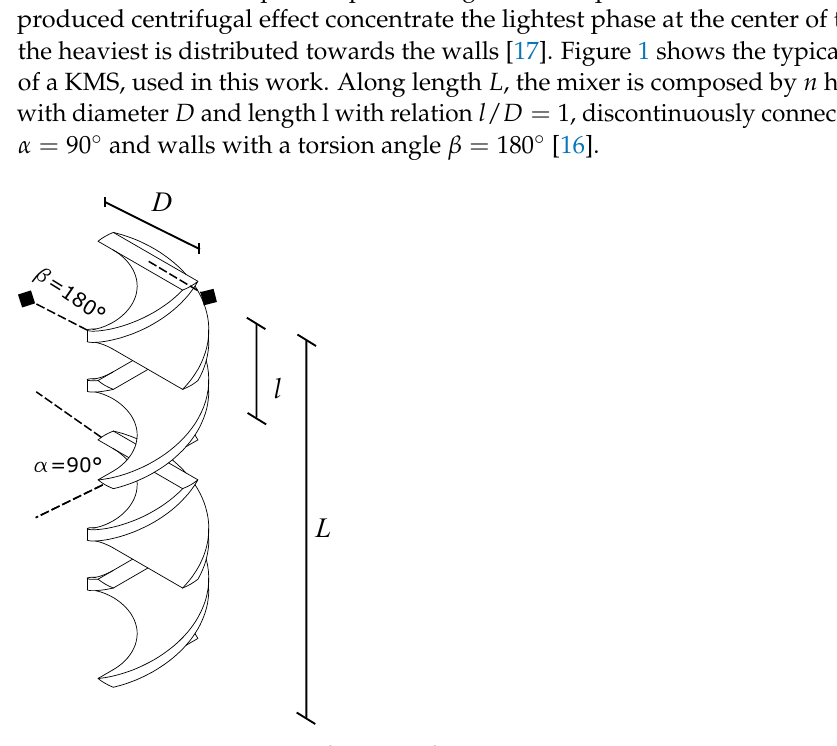
Figure 1. KMS static mixer configuration for n =